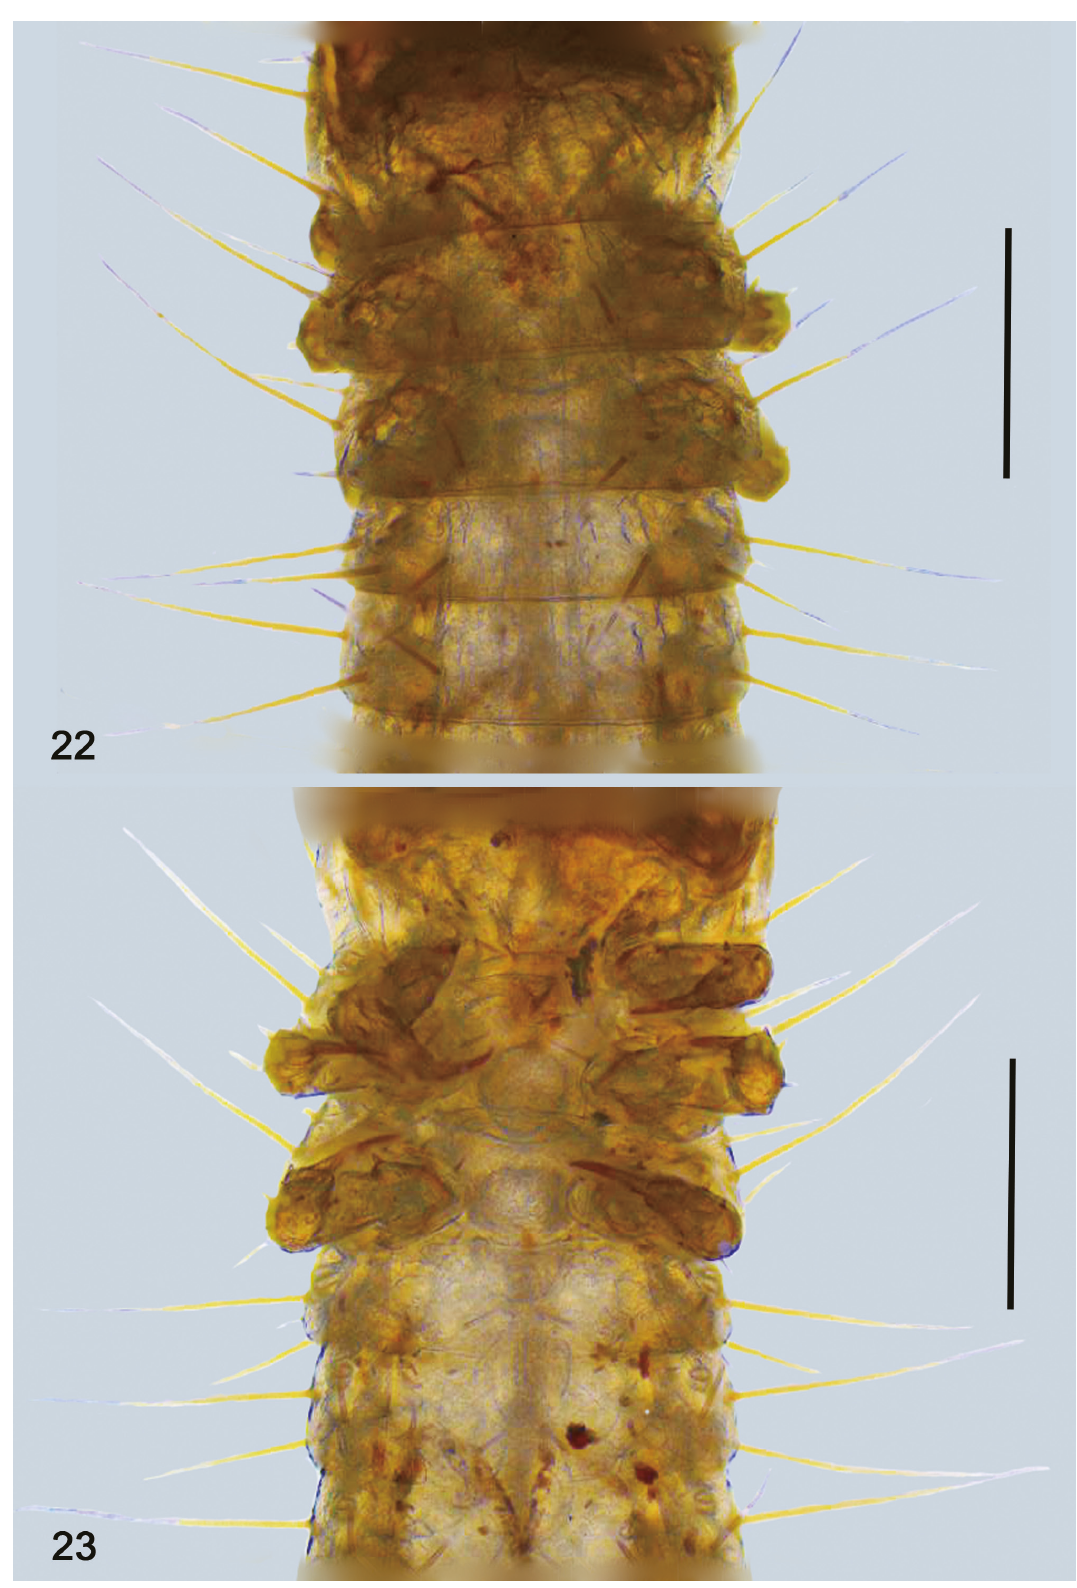
Figs 22–23. Thorax and abdominal segments 4–5 of first instar larva of Trictenotoma formosana Kriesche, 1919. 22 . Dorsal view. 23 . Ventral view. Scale bars: